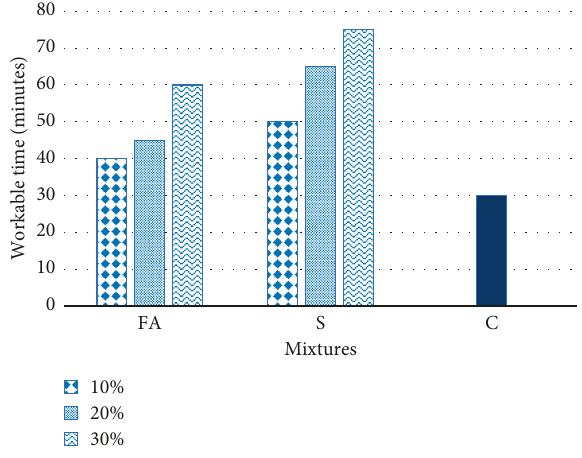
Figure 7: Workable time test results.